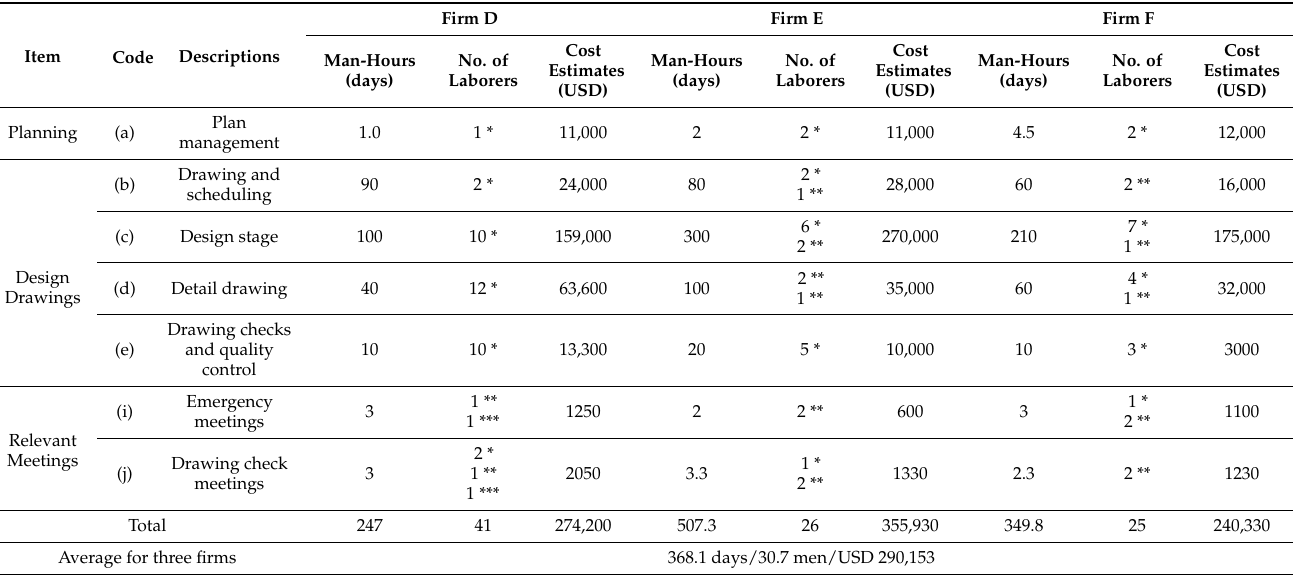
Table 5. Man-hours and the number of laborers for non-BIM